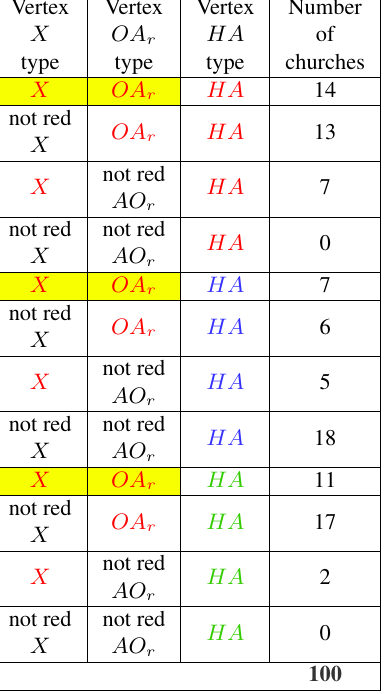
Table 1: Simulated statistical data: each line of the table contains the number of examples to generate the conditional